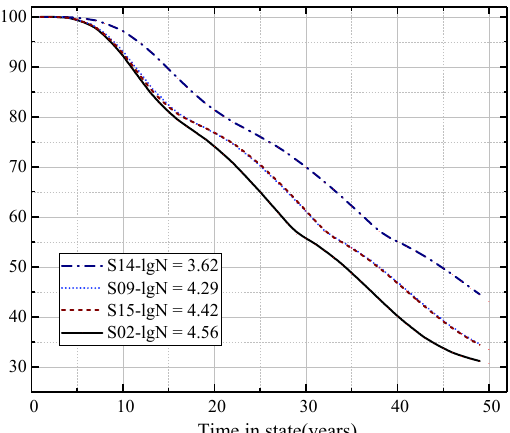
Figure 7. Prediction of PCI for the model with a different aircraft traffic volume (H = 32 cm).